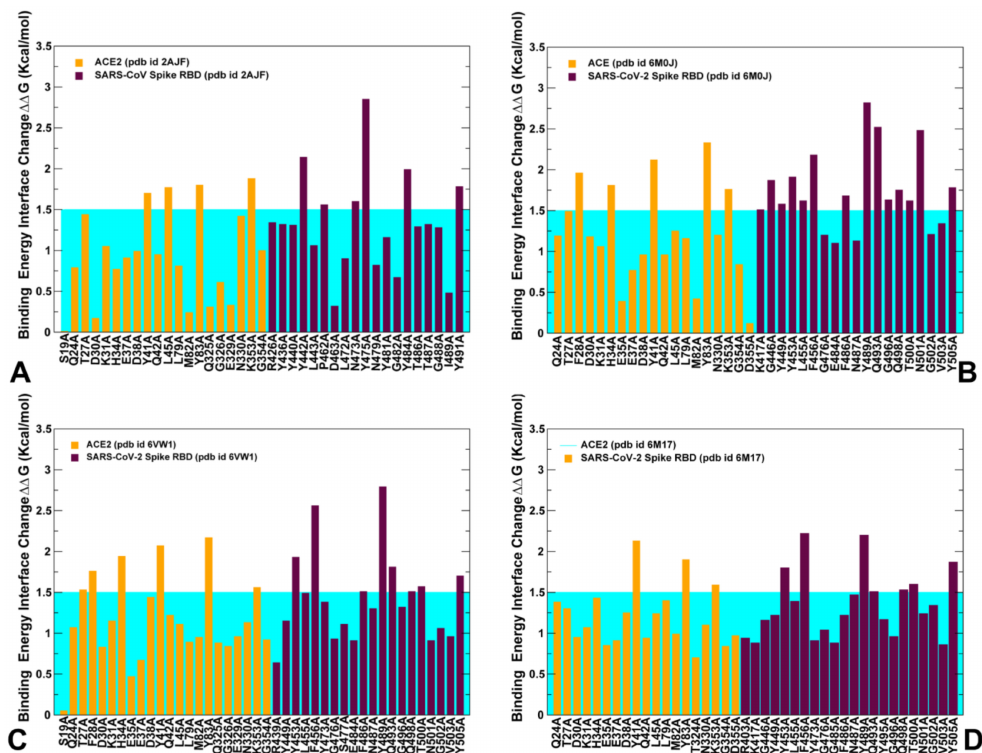
Figure 10. Alanine scanning of the key binding interface residues in the SARS-CoV and SARS-CoV-2 complexes with ACE2. ( A ) The binding free energy changes upon alanine mutations for the interface residues in the SARS-CoV-RBD complex with ACE2 (pdb id 2AJF). The binding energy changes for the ACE residues are shown in orange bars and for the SARS-CoV-RBD interacting residues in maroon bars. The computed values were obtained using BeAtMuSiC approach and were averaged over equilibrium samples from MD simulation. ( B ) The binding free energy changes upon alanine mutations for the interface residues in the SARS-CoV-2 RBD complex with ACE2 (pdb id 6M0J). The binding energy changes for the ACE residues are shown in orange bars and for the SARS-CoV-2 RBD interacting residues in maroon bars. ( C ) The binding free energy changes upon alanine mutations for the interface residues in the engineered chimera SARS-CoV-2 RBD bound with ACE2 (pdb id 6VW1). The binding energy changes for the ACE residues are shown in orange bars and for the SARS-CoV-2 RBD interacting residues in maroon bars. ( D ) The binding free energy changes upon alanine mutations for the interface residues in the SARS-CoV-2 RBD complex with ACE2 obtained from the cryo–electron microscopy structure of the full-length human ACE2 with SARS-CoV-2 RBD in the presence of the neutral amino acid transporter B 0 AT1 (pdb id